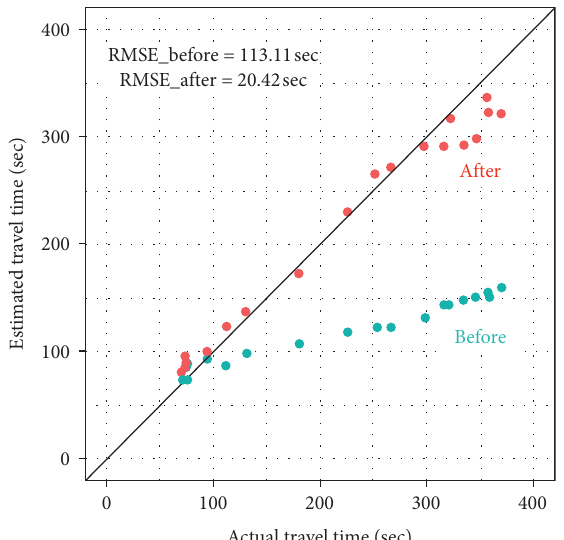
Figure 10: Parity plot of travel time estimation before and after applying the proposed framework (at MPR 30%).